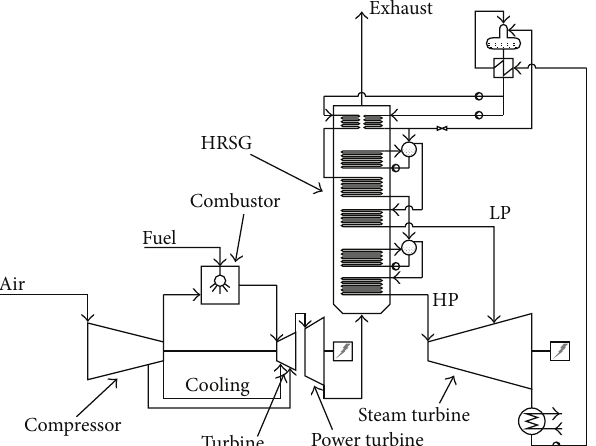
Figure 1: Schematic layout of the reference cycle.